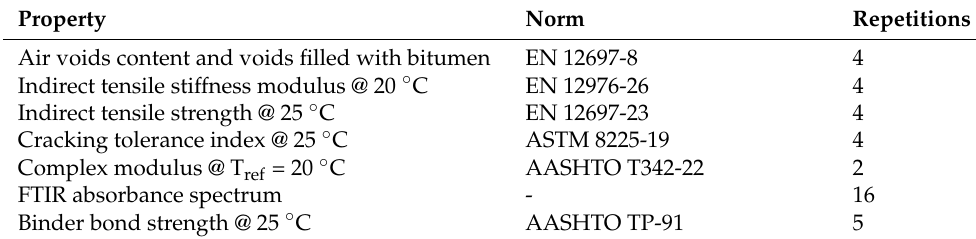
Table 2. Experimental